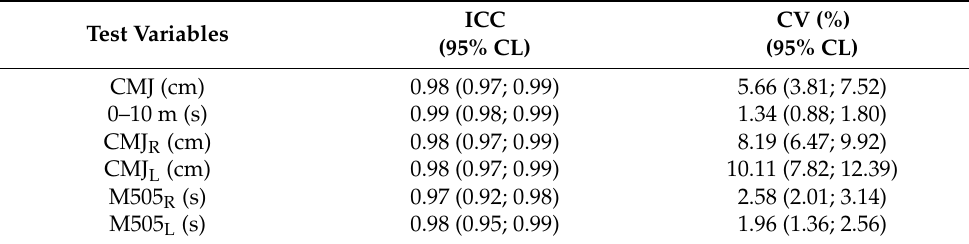
Table 2. Reliability data for test variables. Data are presented as value with lower- and -upper confidence